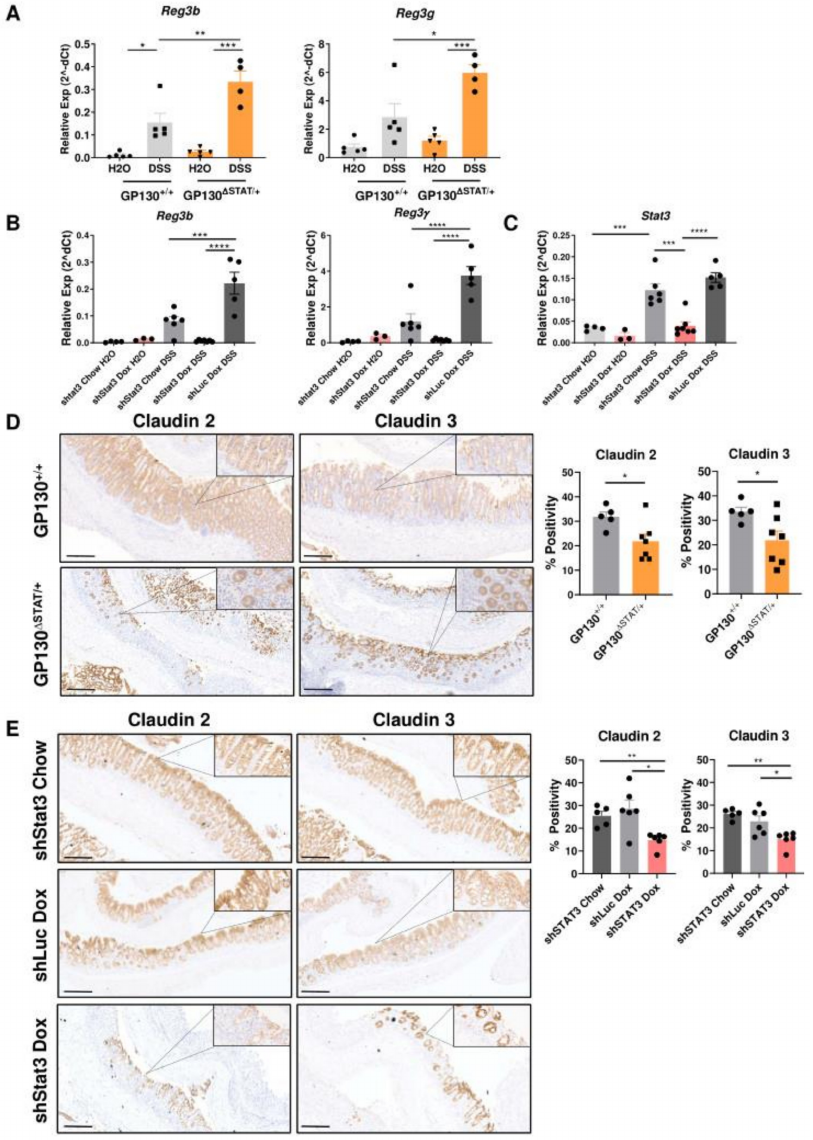
Figure 5. Reduction in STAT3 activity impairs expression of antimicrobial genes and tight junction proteins. The gene expression of Reg3b and Reg3g ( A , B ) and Stat3 ( C ) was analysed in colonic lysates from each cohort using real-time quantitative PCR in technical duplicate ( n = 3–6 per experimental group). Data represent relative expression normalised against the housekeeping gene Gapdh, with mean ± SEM. Immunohistochemistry analysis of claudin 2 and claudin 3 of colons harvested from ( D ) GP130 +/+ and GP130 ∆ STAT/+ and ( E ) shStat3 Chow, shStat3 Dox, and shLuc at experimental endpoint ( n = 5–7 per experimental group). Data represent mean ± SEM. Data were checked for normal distribution with Kolmogorov–Smirnov test and statistical analysis was performed using ( A , B , E ) one-way ANOVA with Tukey’s multiple comparisons test or ( D ) unpaired Student’s t -test. Scale bar: 200 µ m. * p < 0.05; ** p < 0.01. Reg3 : Regenerating islet-derived